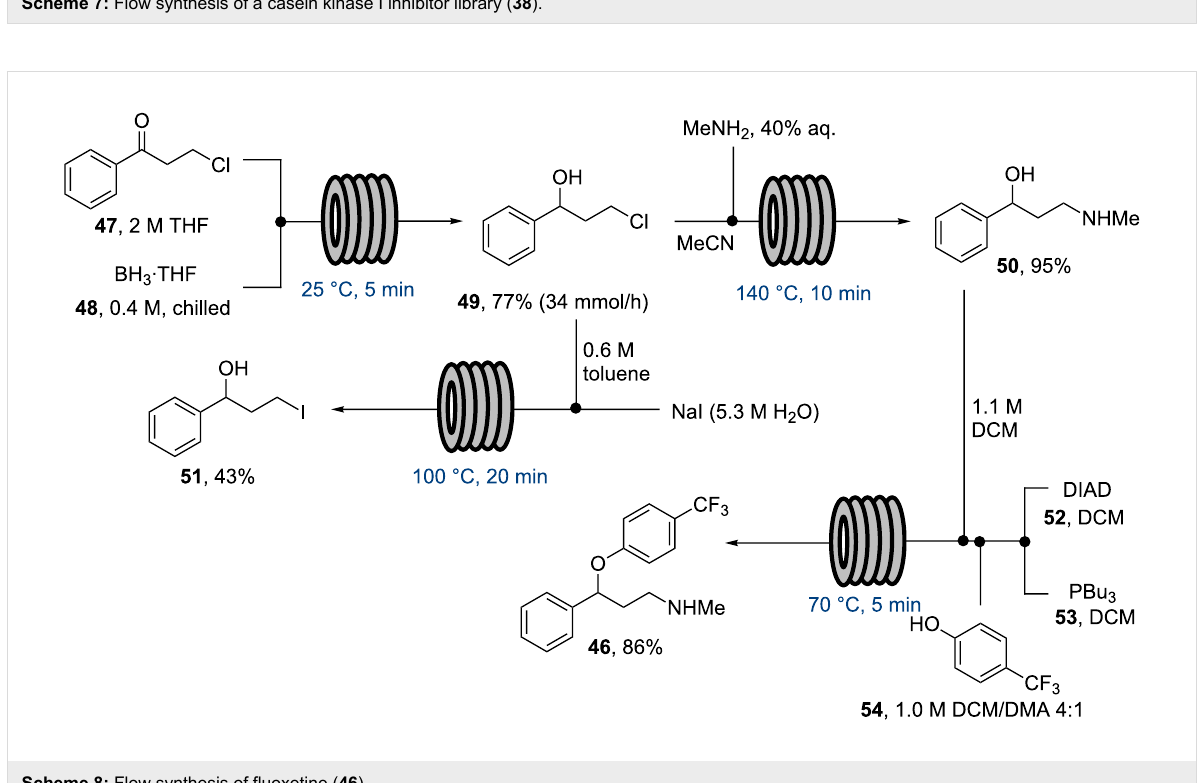
Scheme 8: Flow synthesis of fluoxetine ( 46